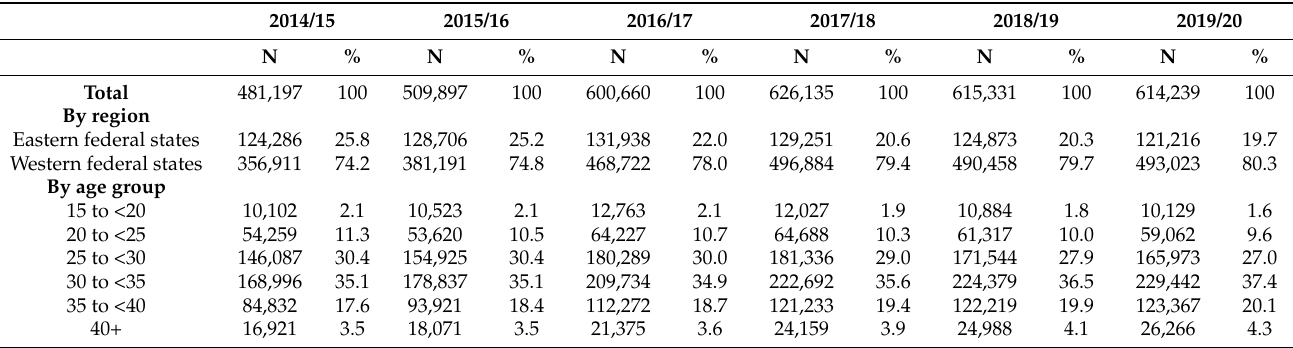
Table 1. Number and distribution of pregnant women eligible for influenza vaccination based on outpatient claims data, by region and age group, seasons 2014/15 to